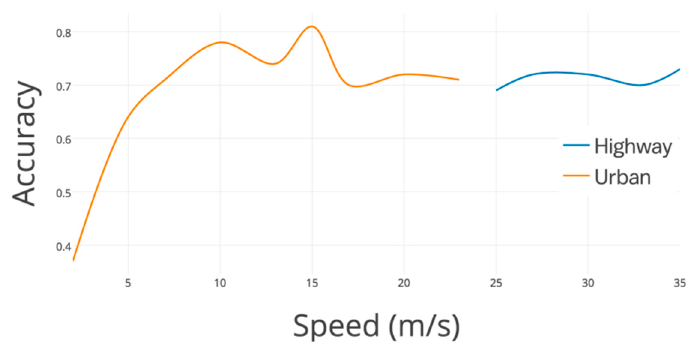
Figure 13. Real-time lane-changes detected accuracy with different speed on urban road and highway.